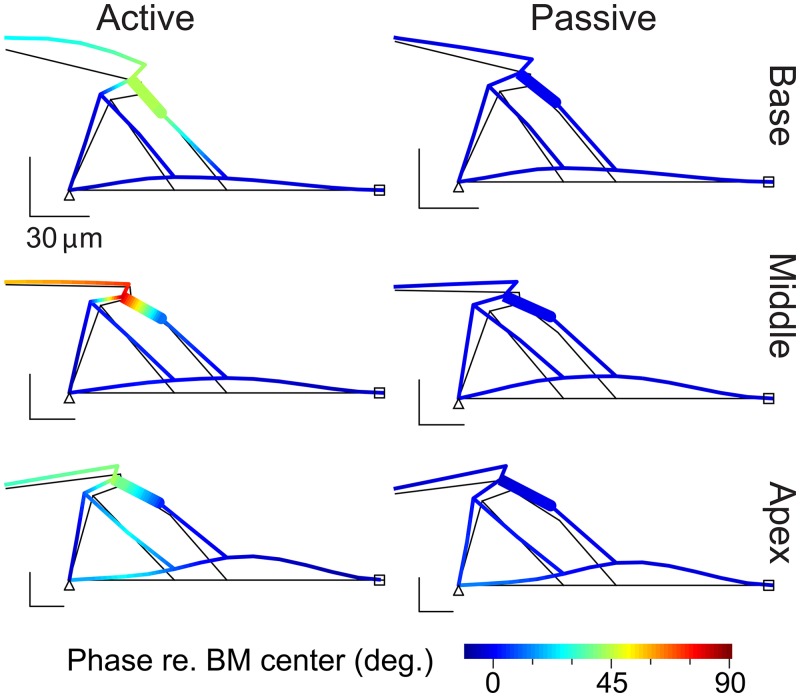
Phase difference between OCC structures.The deformed shape of the vibrating OCC is taken when the BM is displaced most under pure tone stimulation at the best frequency. Colors of the deformed OCC structures indicate the phase of the structures’ transverse (z) displacement with respect to the BM displacement below the Deiters cell. Six cases represent when the cochlea is active or passive at three different longitudinal locations corresponding to the six peak responses in Fig 2A. The thin black lines indicate the original (non-deformed) geometry. Because of the outer hair cell is tilted out of plane, the structures shown are not exactly in plane. See the movie clips.